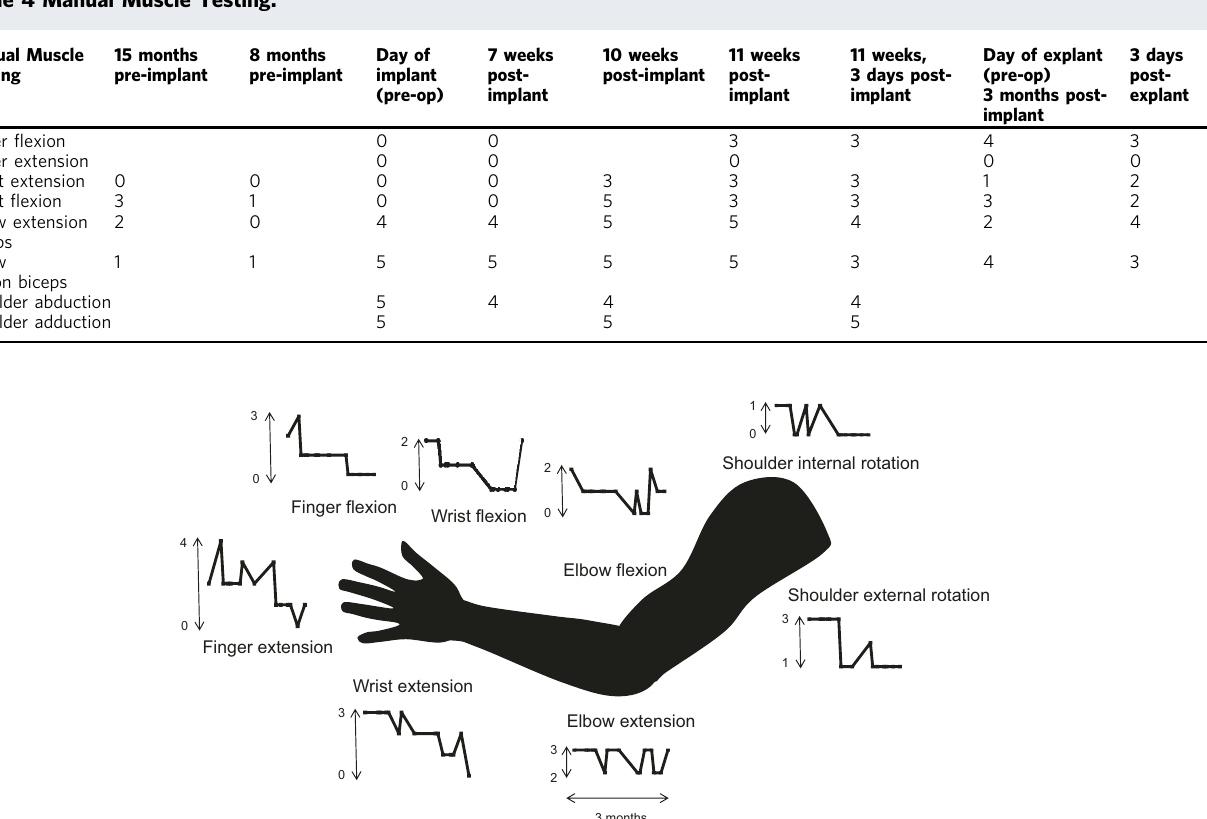
Table 4 Manual Muscle Testing.